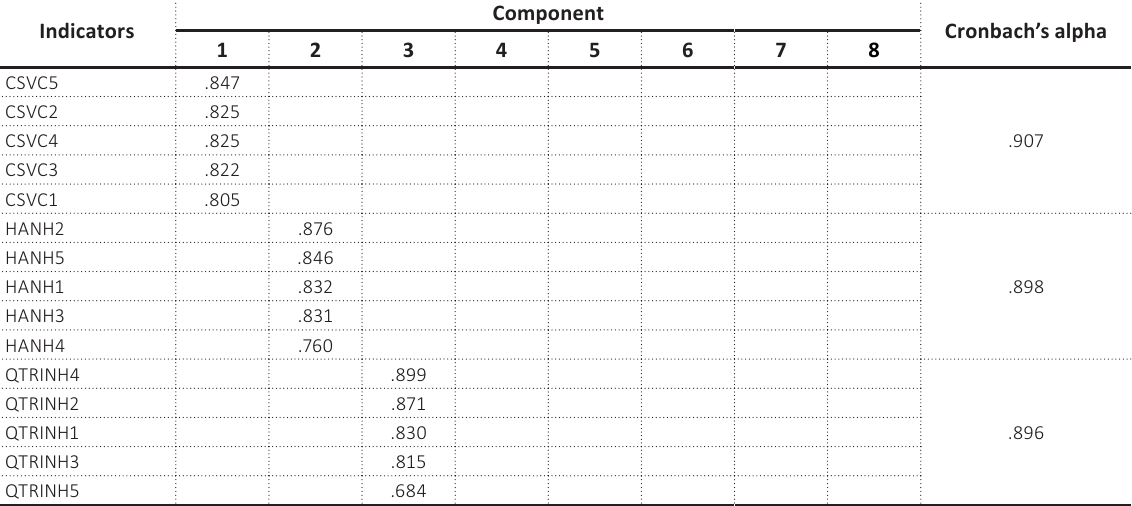
Source: Developed by the authors with